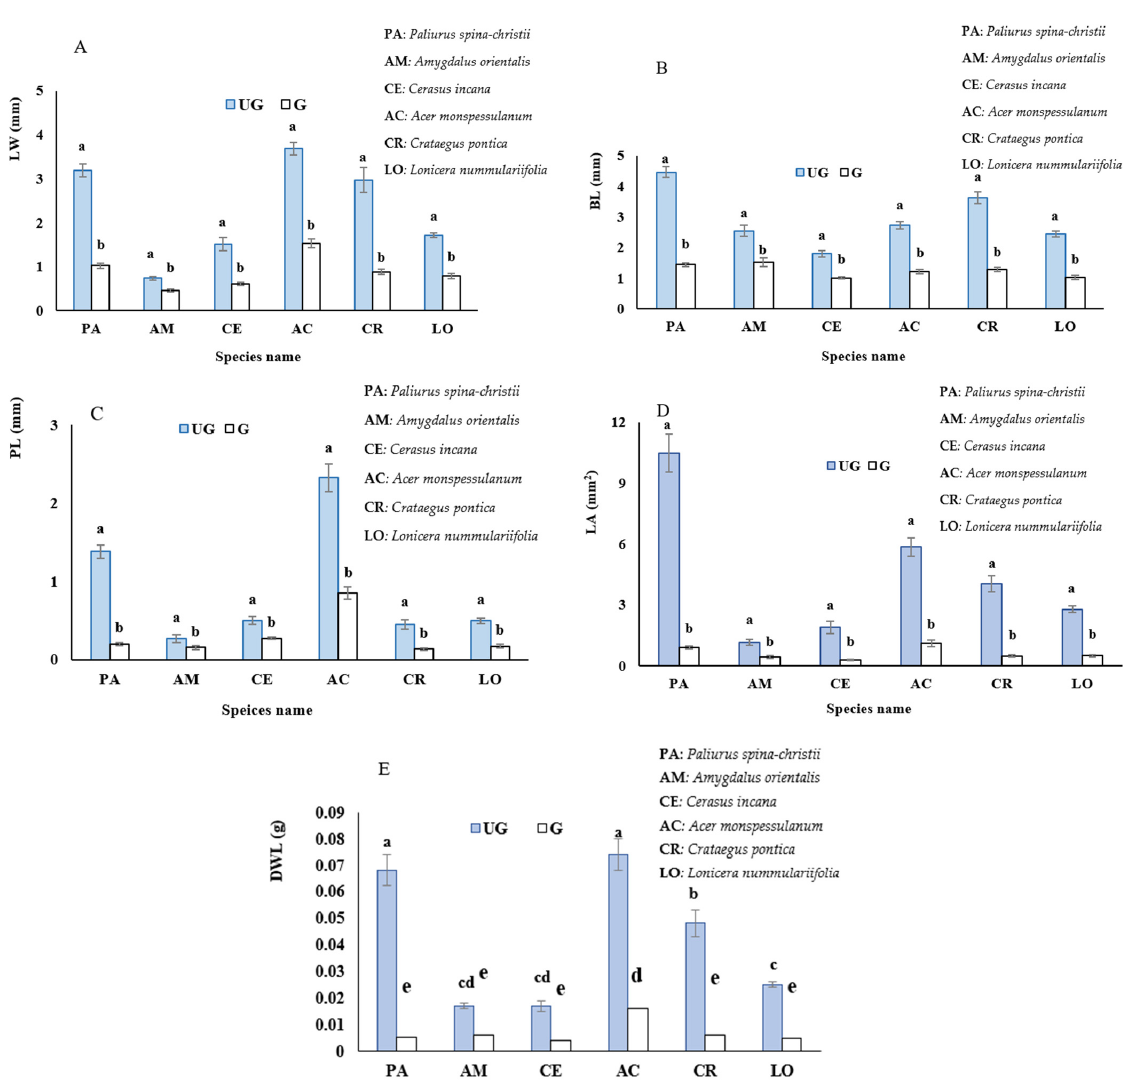
Figure 2. Mean comparison between the leaf traits under two different grazed (G) and un-grazed (UG) stresses. ( A ) Leaf width (mm); ( B ) Leaf length (mm); ( C ) Petiole length (mm); ( D ) Leaf area (mm 2 ), and ( E ) Leaf dry weight (g).